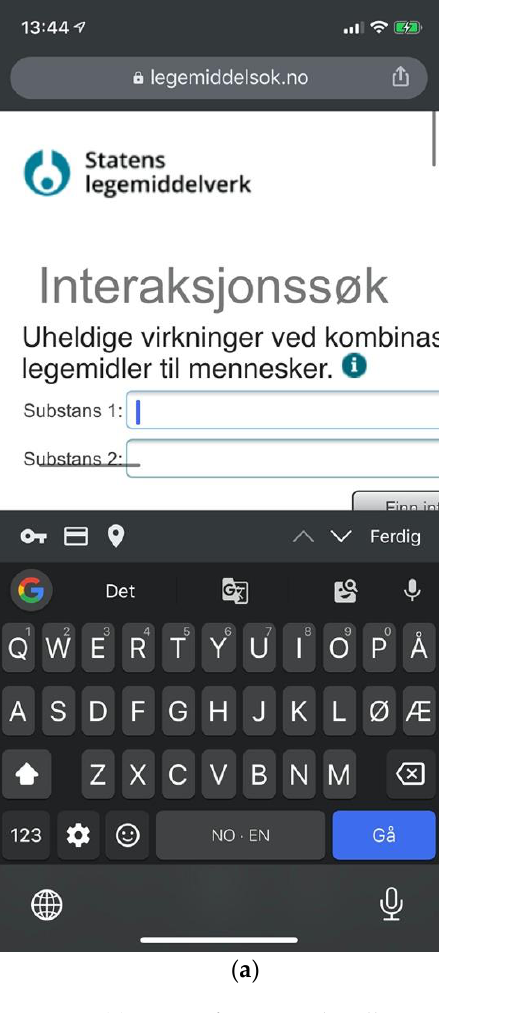
Figure 14. ( a ) Issues of viewport handling prevent usability at Legemiddelsok.no, and no welcoming instructions are provided; ( b ) “Search tips” modal panel sticking outside the viewport.